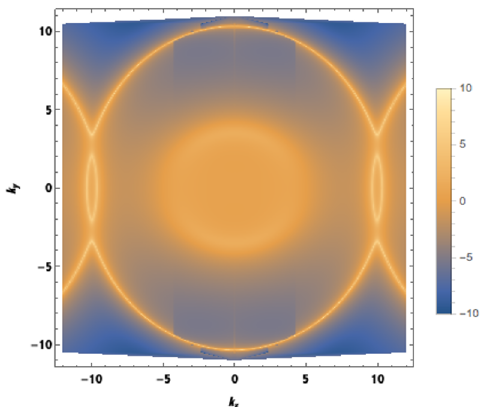
Figure 4. Density Plot of logarithm of the spectral function A over ( k x , k y ) -plane in presence of the ionic lattice with a i = 0 . 2 .